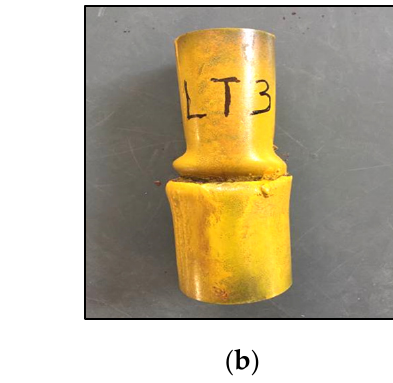
15 of 28 Figure 17. Sleeve shear experimental device.